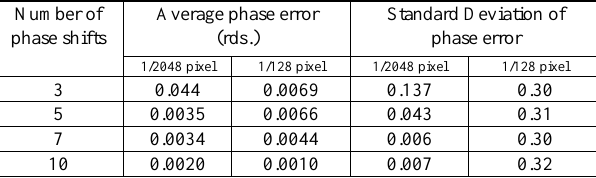
Table 1. Comparison of average phase error of two different spatial frequencies with various phase shifts